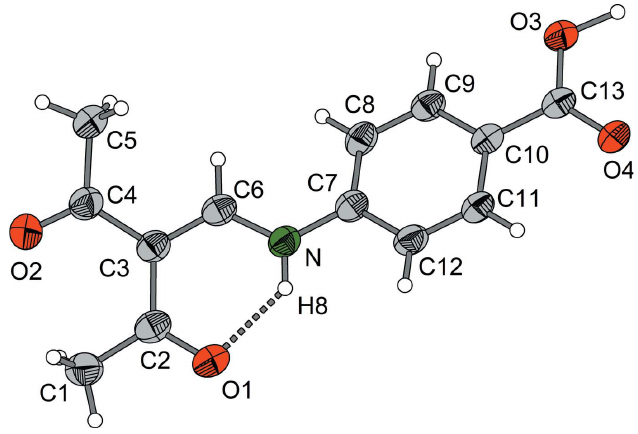
Figure 1 Molecular structure of enamine 1 showing the labelling scheme. Hydrogen bonds are shown as dashed lines; displacement ellipsoids are drawn at the 50% probability level.